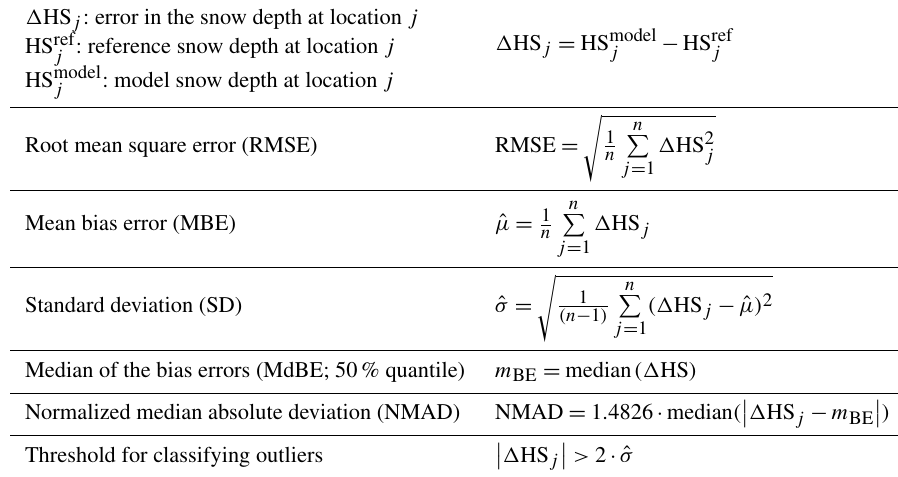
Table 3. Accuracy and precision measures adapted from Höhle and Höhle (2009).